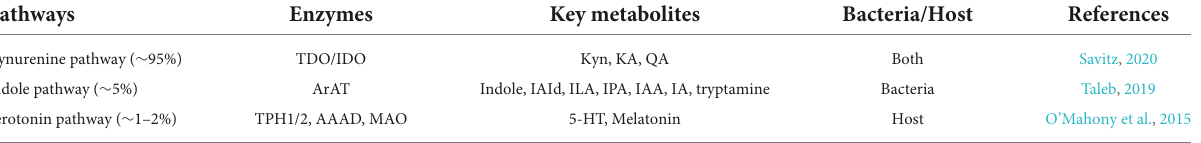
TABLE 1 Summary of tryptophan metabolic pathways in the human